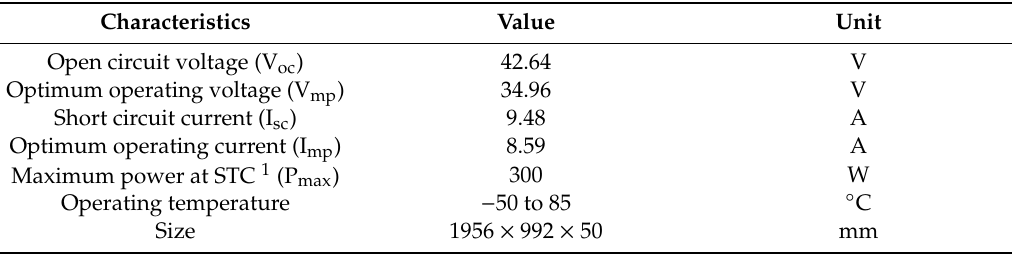
Table 3. Key specifications of the photovoltaic (PV) panels.